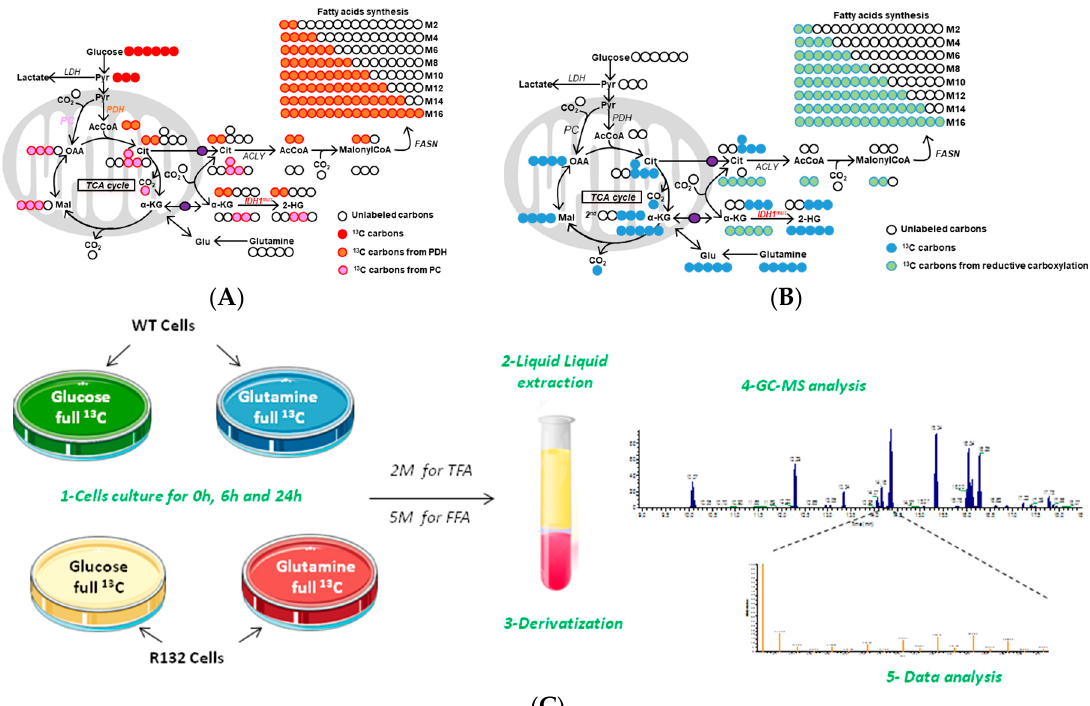
Figure 3. Simplified schematic of carbon atom (circles) transitions and tracers used to detect labeled fatty acids (FAs). ( A ) Isotopic label from [U- 13 C]glucose (red) to 2-HG and FAs synthesis through PC (Pyruvate Carboxylase; pink) or PDH (Pyruvate DeHydrogenase; orange); ( B ) Isotopic label from [U- 13 C]glutamine (blue) to 2-HG and FAs synthesis through classical TCA cycle (blue) or reductive glutamine metabolism (green). ( C ) Experimental design of the isotopic measurement of FAs on WT and IDH1 mutant cells.